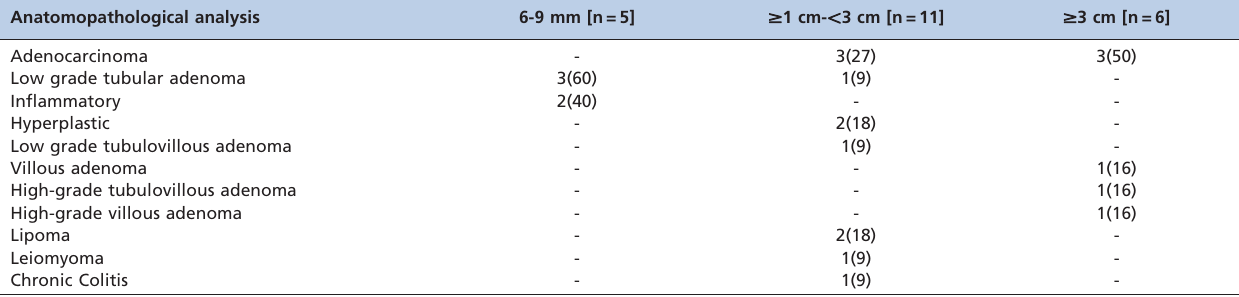
Table 2 - Anatomopathological analysis of lesions $ 6 mm identified in computed tomography colonography and optical colonoscopy.